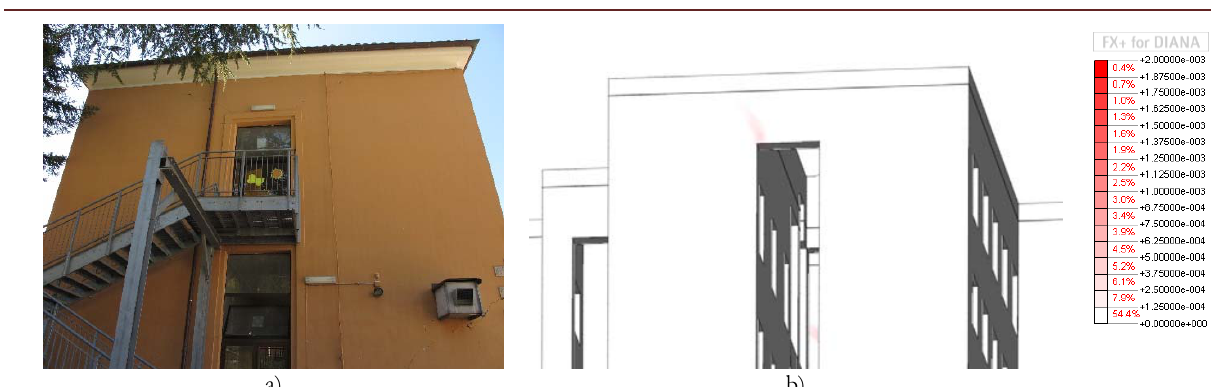
Figure 18: Correlation between the real and numerical damage occurred in the north wall of body B due to the August 24 th earthquake (PGAx = 0.33 g): a) cracks observed in-situ [11, 12], b) crack pattern in terms of principal crack width for a horizontal load of 0.33 g in the -X direction.